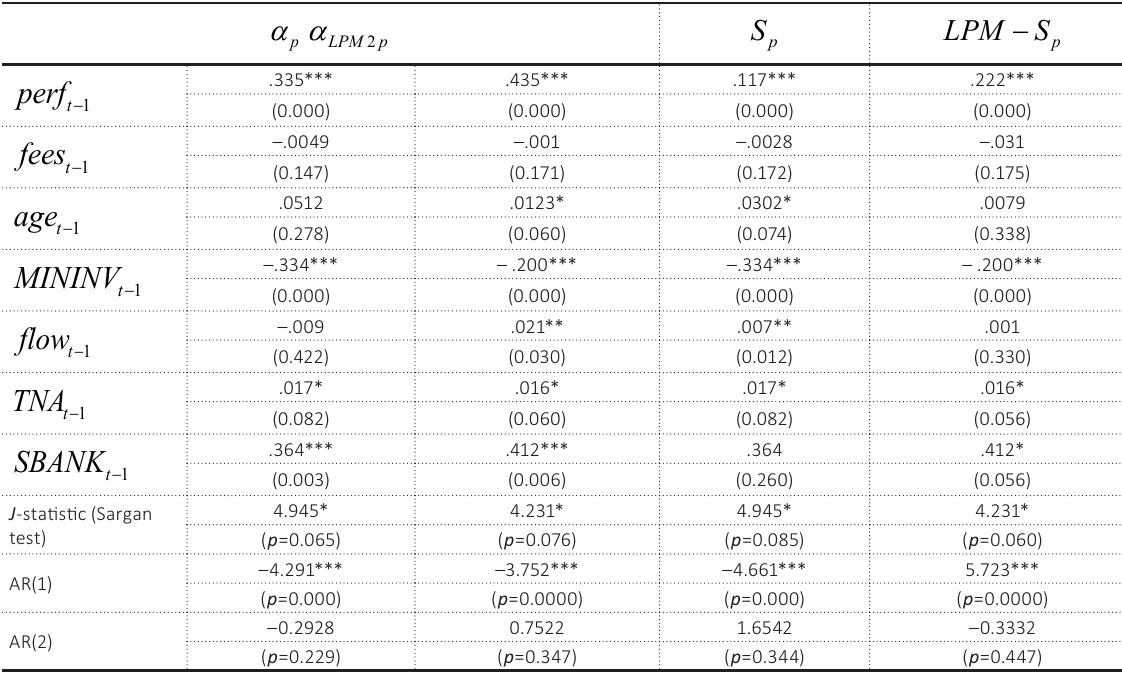
Table 4. Influence of fund-specific factors on future performance for the full